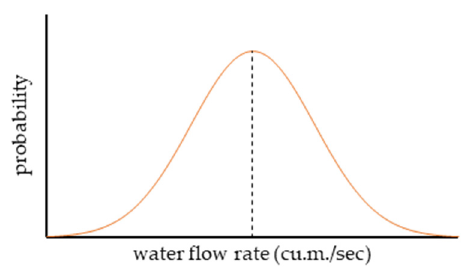
Figure 10. Mass flow rate model with